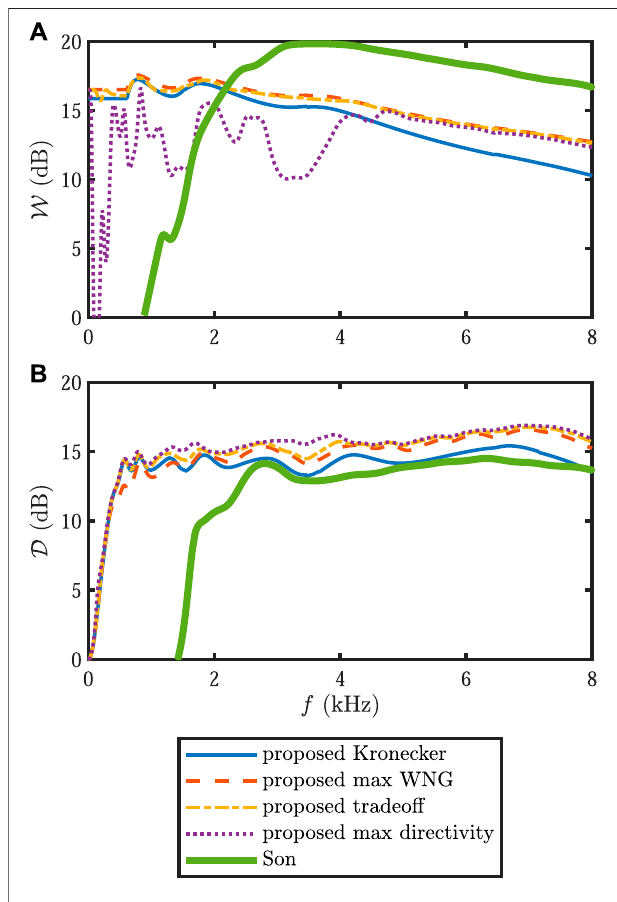
FIGURE11|(A) WNG,and (B) narrowbanddirectivityfactorasafunctionof frequency: Kronecker (solid line), max WNG (dashed line), tradeoff (dash-dot line), maxdirectivity(dottedline),andSon(thicksolidline).Theobtained W [ 890 Hz , 8 kHz ] are respectively 13.5, 15.0, 14.9, 13.0, and 13.1 dB. The obtained D I [ 890 Hz , 8 kHz ] are respectively 14.4, 15.2, 15.5, 15.8, and 6.1